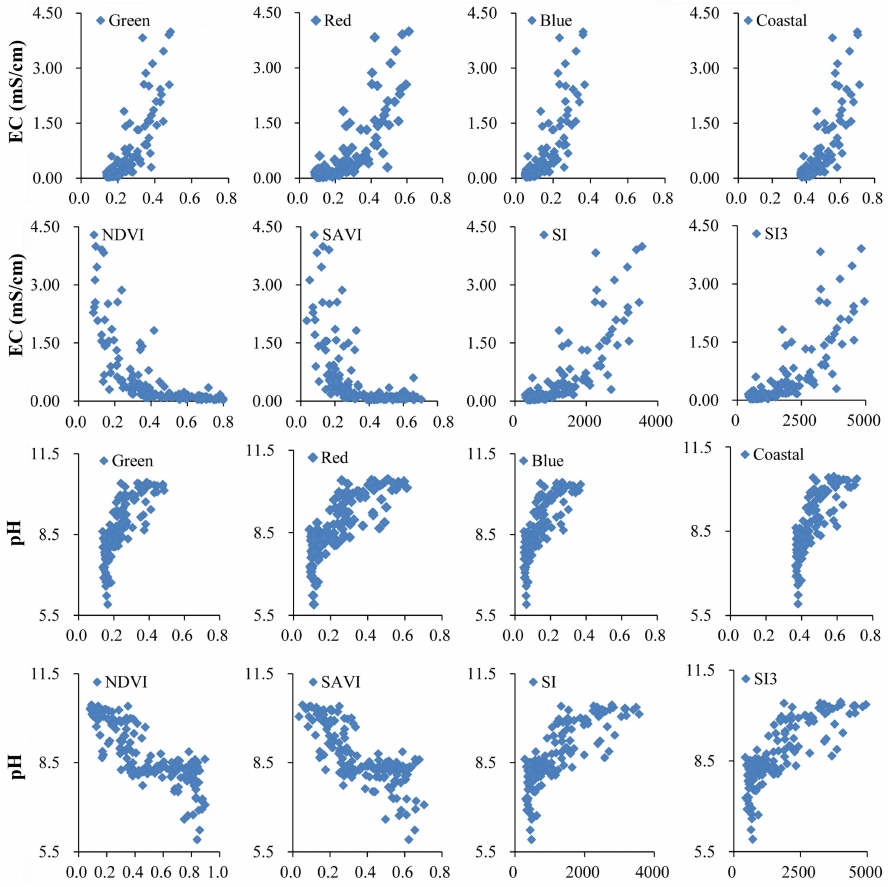
Figure 8. Correlations between optimal variables and soil EC and pH